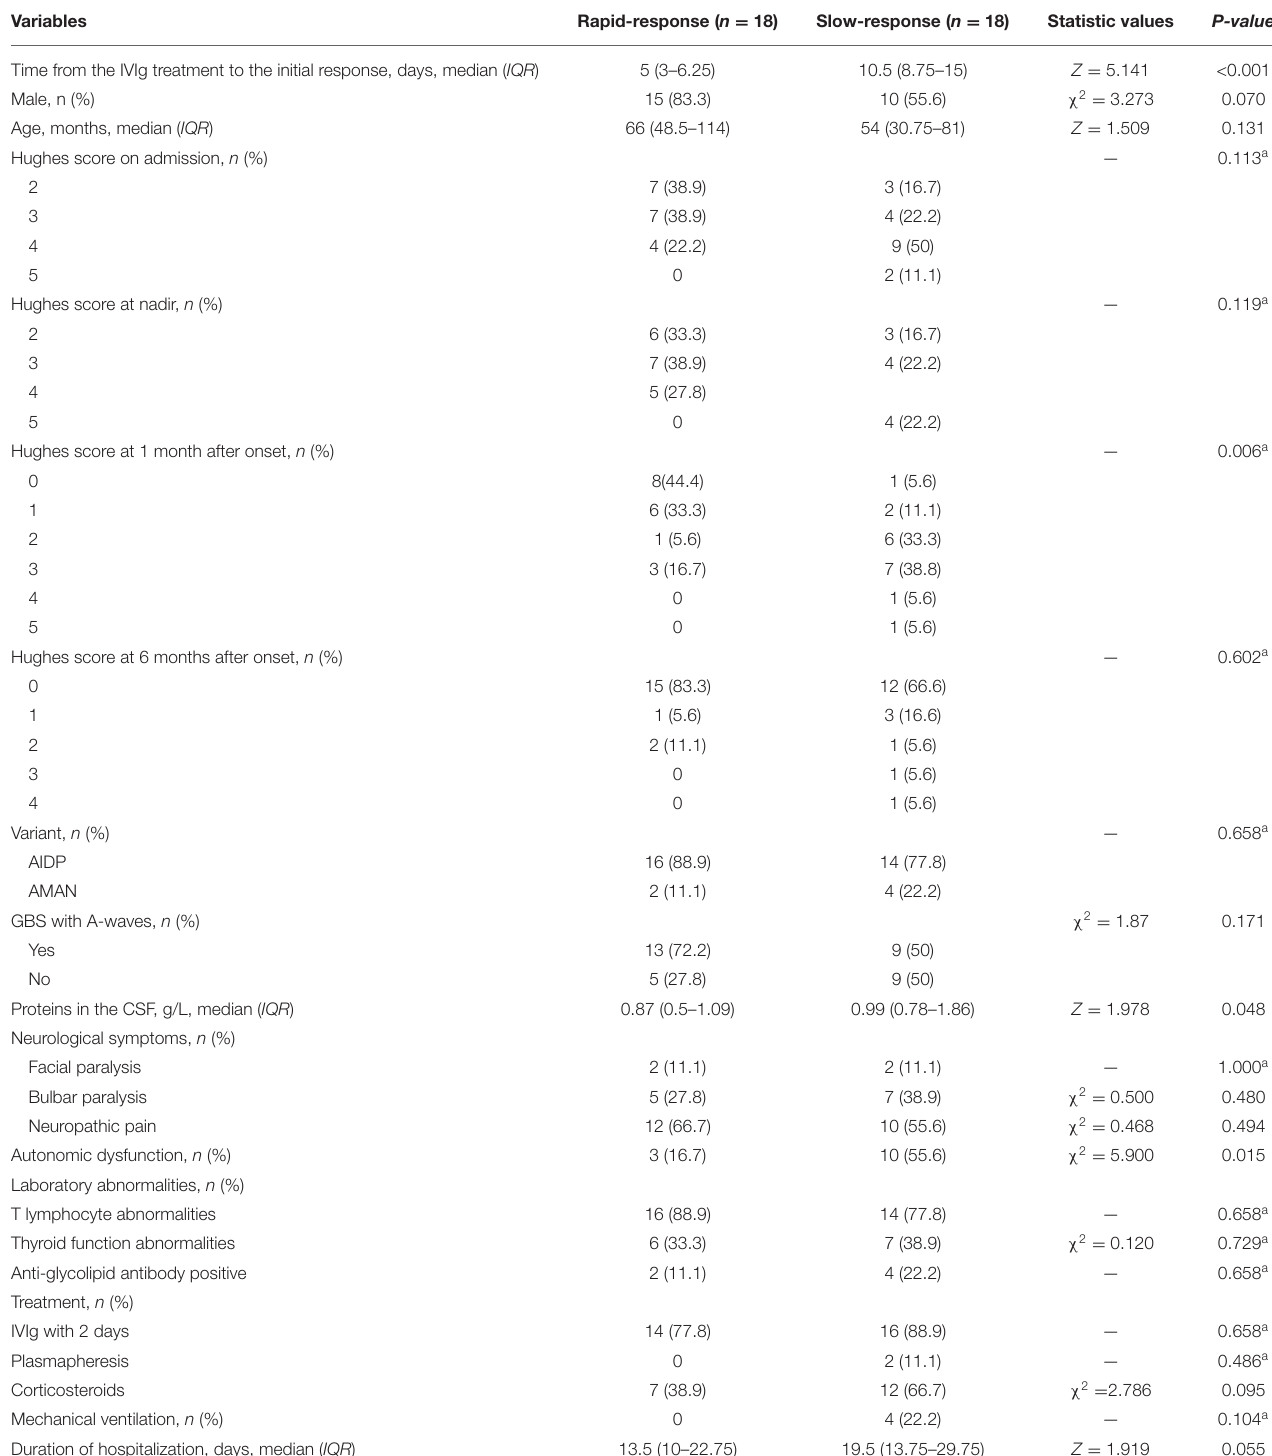
TABLE 1 | Sociodemographic and clinical features of patients with childhood GBS. Variables Rapid-response ( n = 18) Slow-response ( n =